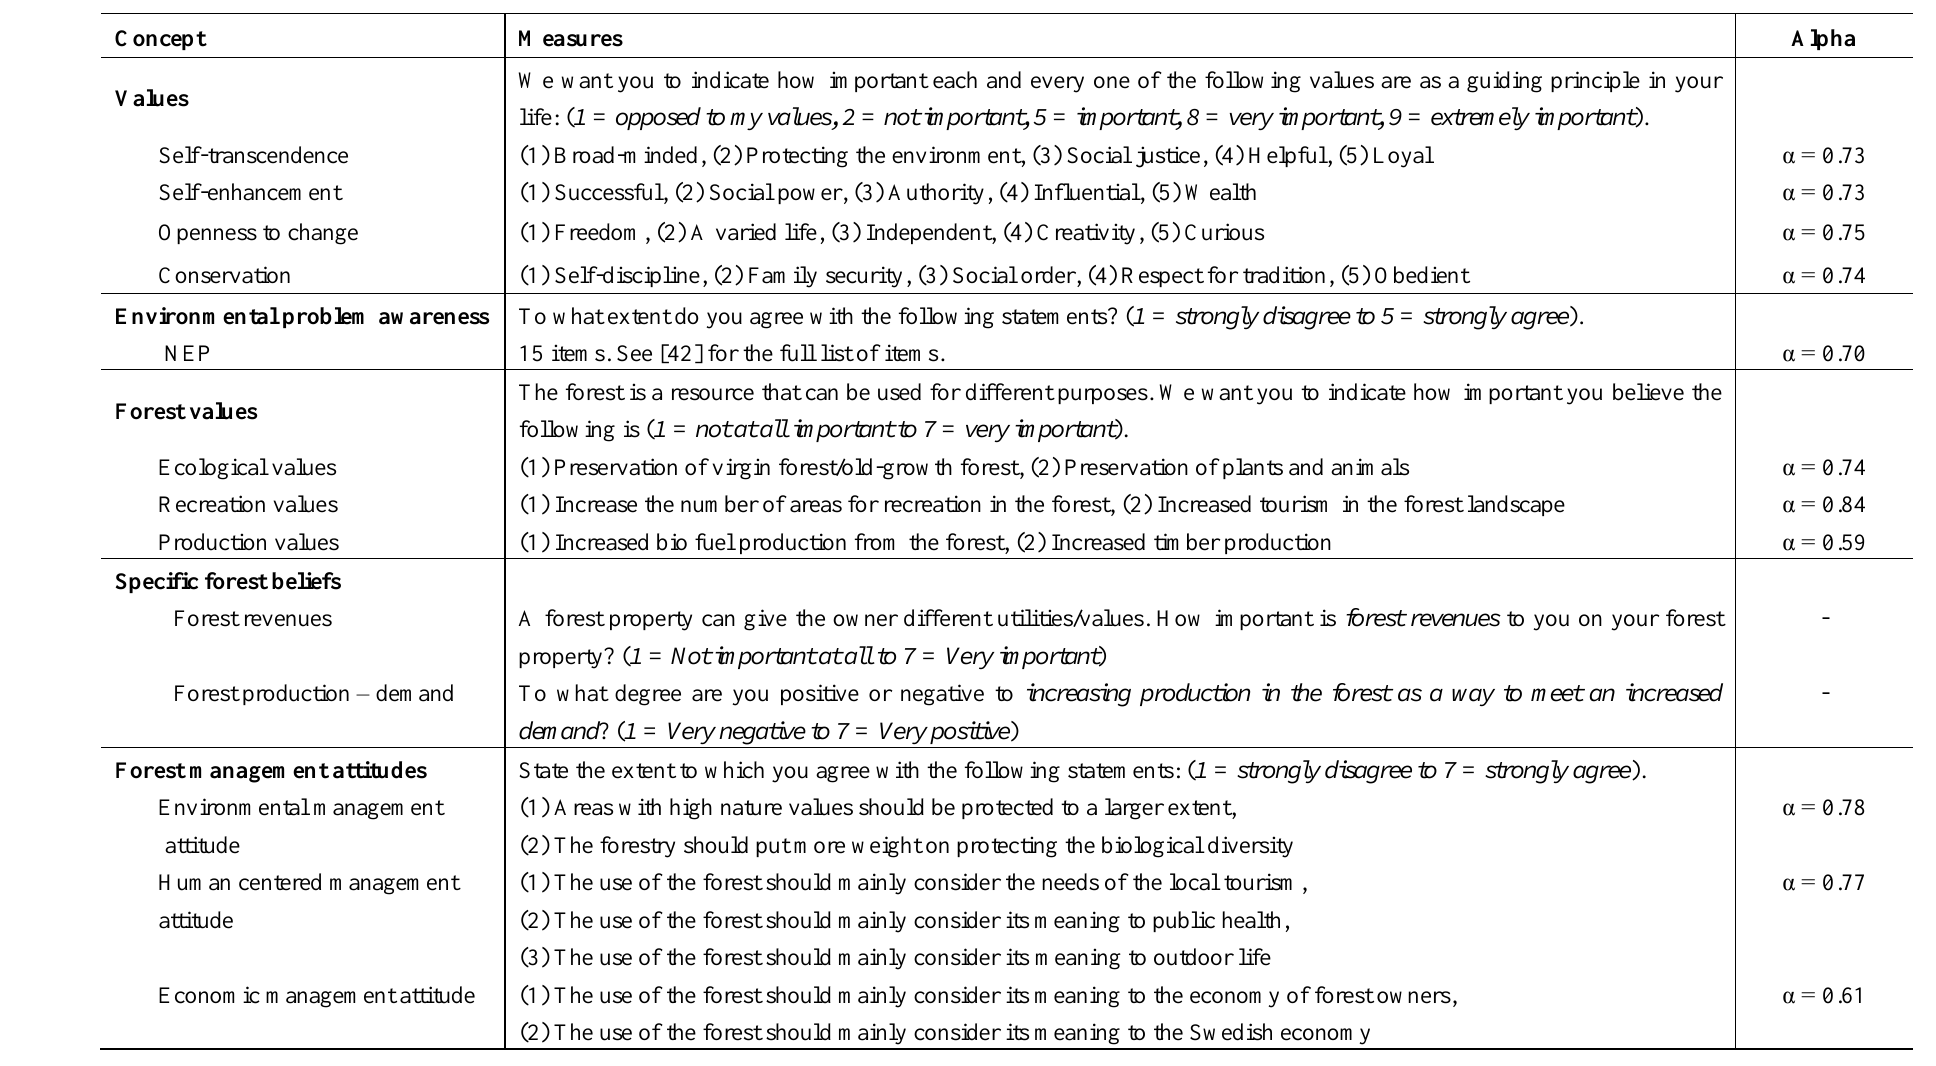
Table 1. An overview of the measures in the